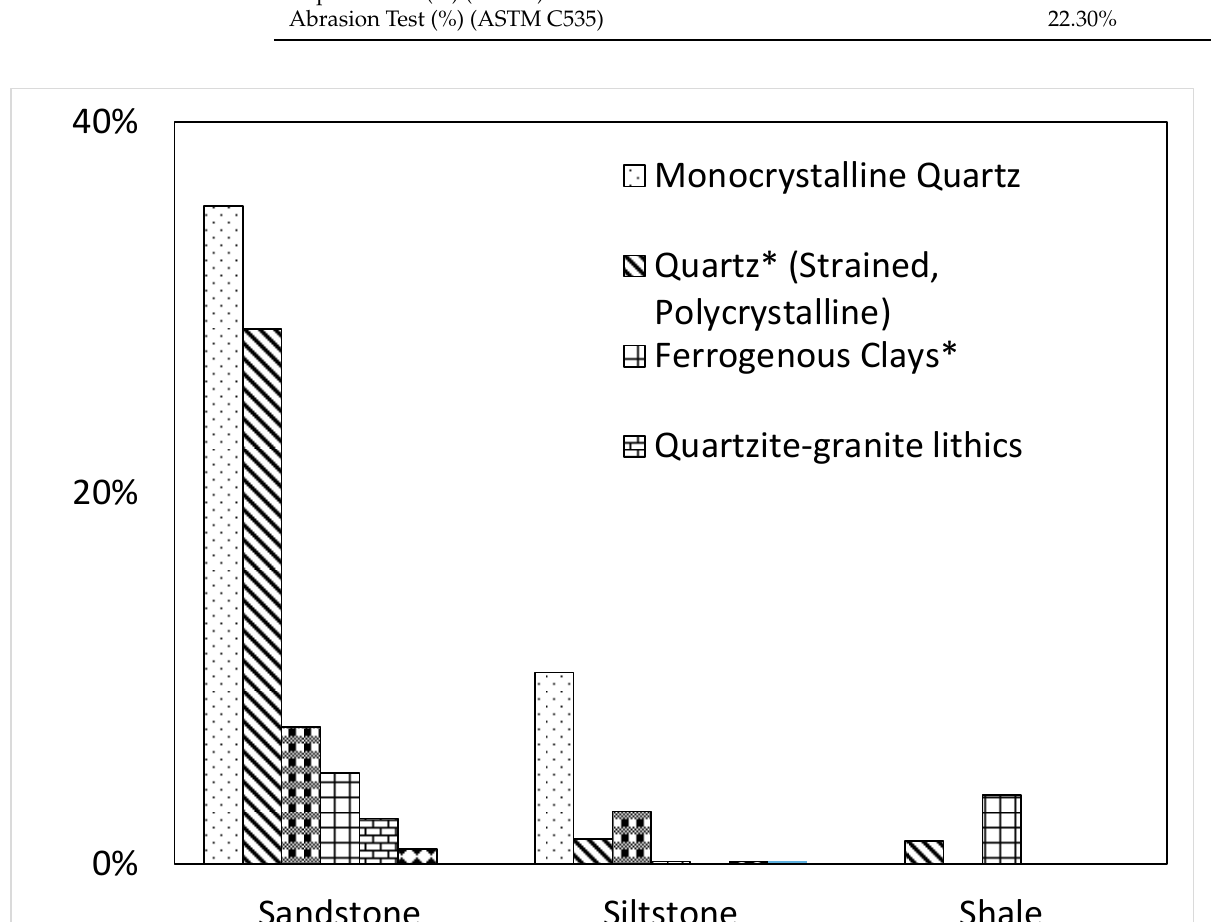
Figure 3. Petrographic examination of aggregates (* reactive components) Table 4. Chemical and physical properties of aggregates used in mixtures.